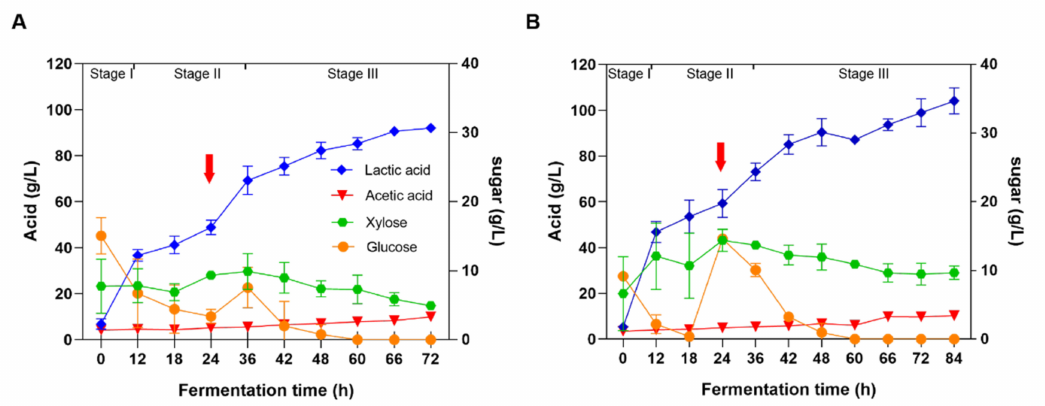
Figure 3. Lactic acid production from NaOH-pretreated and washed corn stover. ( A ) Initial 8% ( w / w ) NaOH-pretreated and washed corn stover was fed with the stover treated in the same manner at hour 24 to reach the final concentration of 12.0% ( w / w ). ( B ) Initial 8% ( w / w ) NaOH-pretreated and washed corn stover was fed with the stover treated in the same manner at hour 24 to reach the final concentration of 15.0% ( w / w ). Substrate and enzyme feedings are indicated by red arrows. The final cellulase concentration in both experiments was 30 FPU / g stover. Diamonds indicate lactic acid. Inverted triangles represent acetic acid. Dots indicate glucose. Polygons represent xylose. The three fermentation stages are presented in the